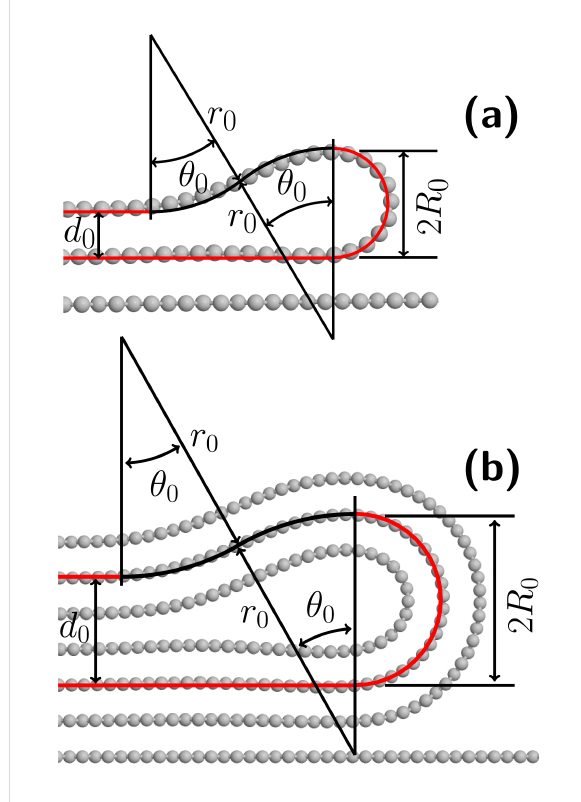
Figure 2: Carbon atom positions (gray circles) in cross sections of folded edges in (a) monolayer graphene and (b) three-layered graphene, as obtained through MD simulations. In both panels the red and black lines that superimpose the atomic positions depict the geom- etry of folded edges within our variational model, which consists of a sequence of straight lines and circular arcs with radii R 0 (red arcs) and r 0 (black arcs). In panel (a), the values of R 0 and r 0 are obtained through our model, Equation 1 and Equation 2, using experimental values of d 0 , κ and α . In panel (b), R 0 and r 0 were obtained through MD simulations.